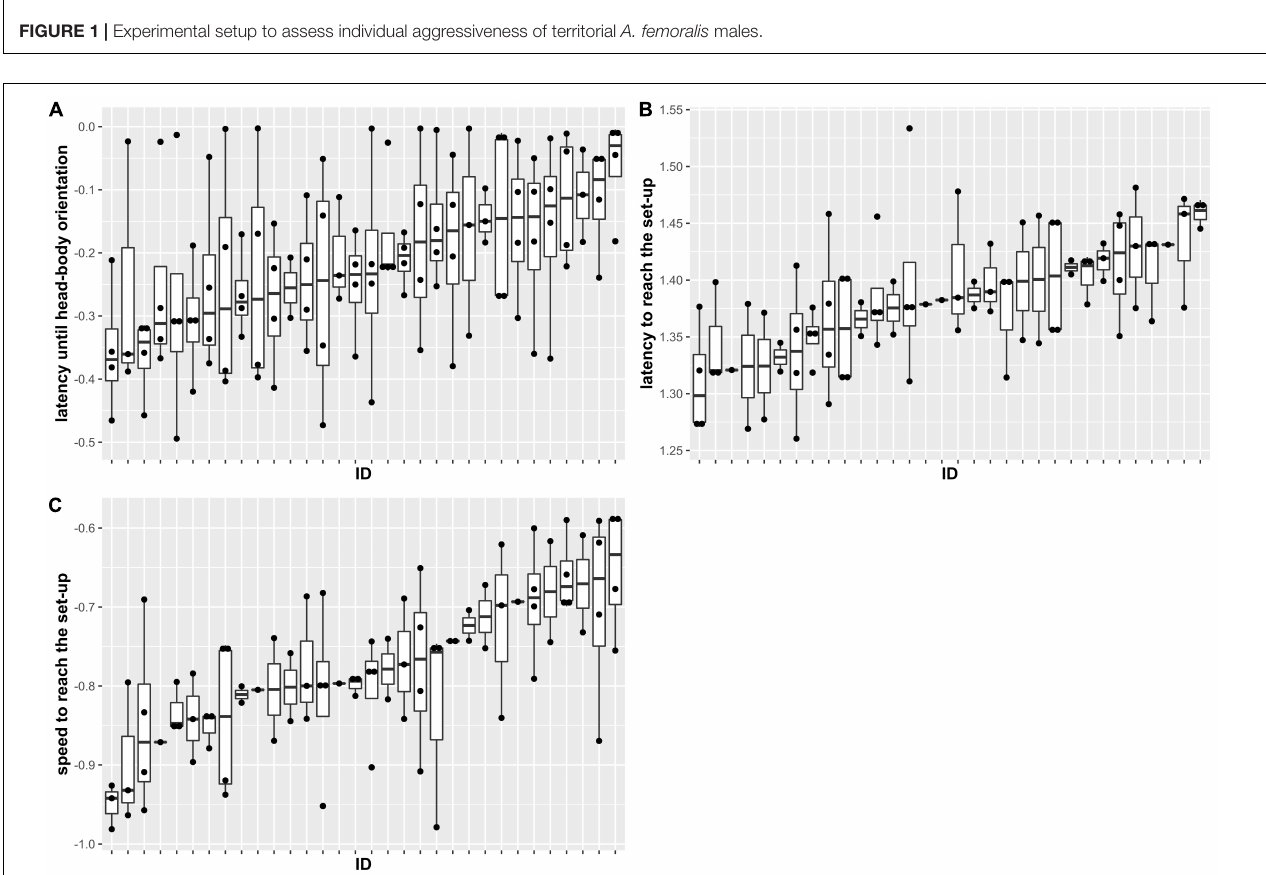
FIGURE 2 | Latency to first head-body orientation (A) , latency to arrive at the speaker (B) , and speed to arrive at the speaker (C) for each of the 32 individual males. All variables have been transformed using a constant transformation. Males are ordered by amount of individual variation. For each individual, the dots represent the results of each of the trials in which the individual reacted to the speaker, while the horizontal bold line represents the median across these four trials. The upper and lower horizontal lines delimiting the boxes represent the first and third